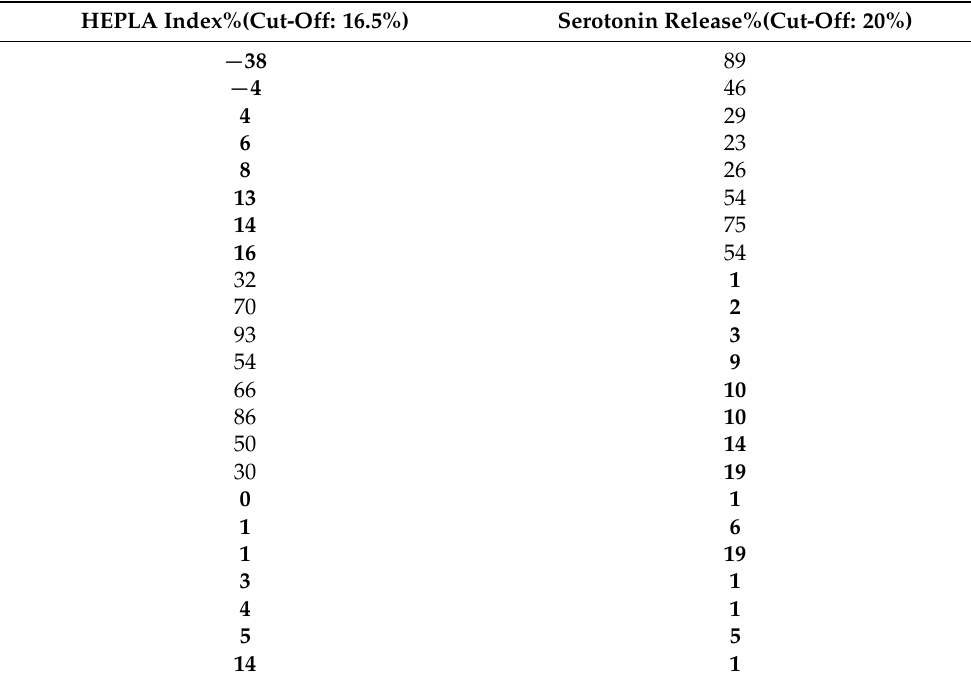
Table 6. Values of the HEPLA index (%) and serotonin release (%) for false negative results of FCA and/or SRA. The values of the false negative results are in bold.